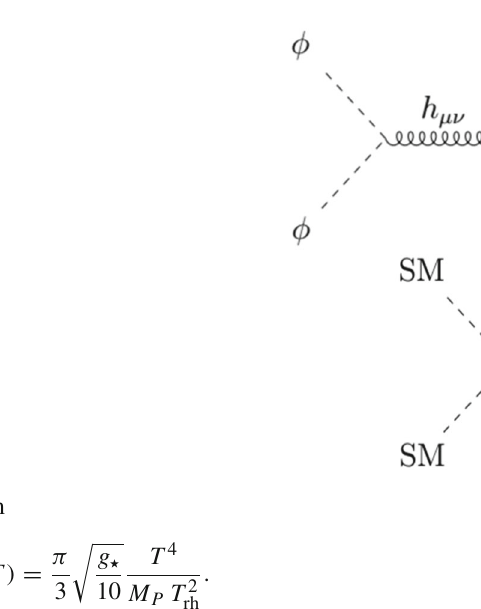
Fig. 3 Feynman diagrams for the different DM productions channels described in the text. The three rows correspond to (i) the decay of the inflaton, (ii) inflaton scatterings, and (iii) the scattering of SM